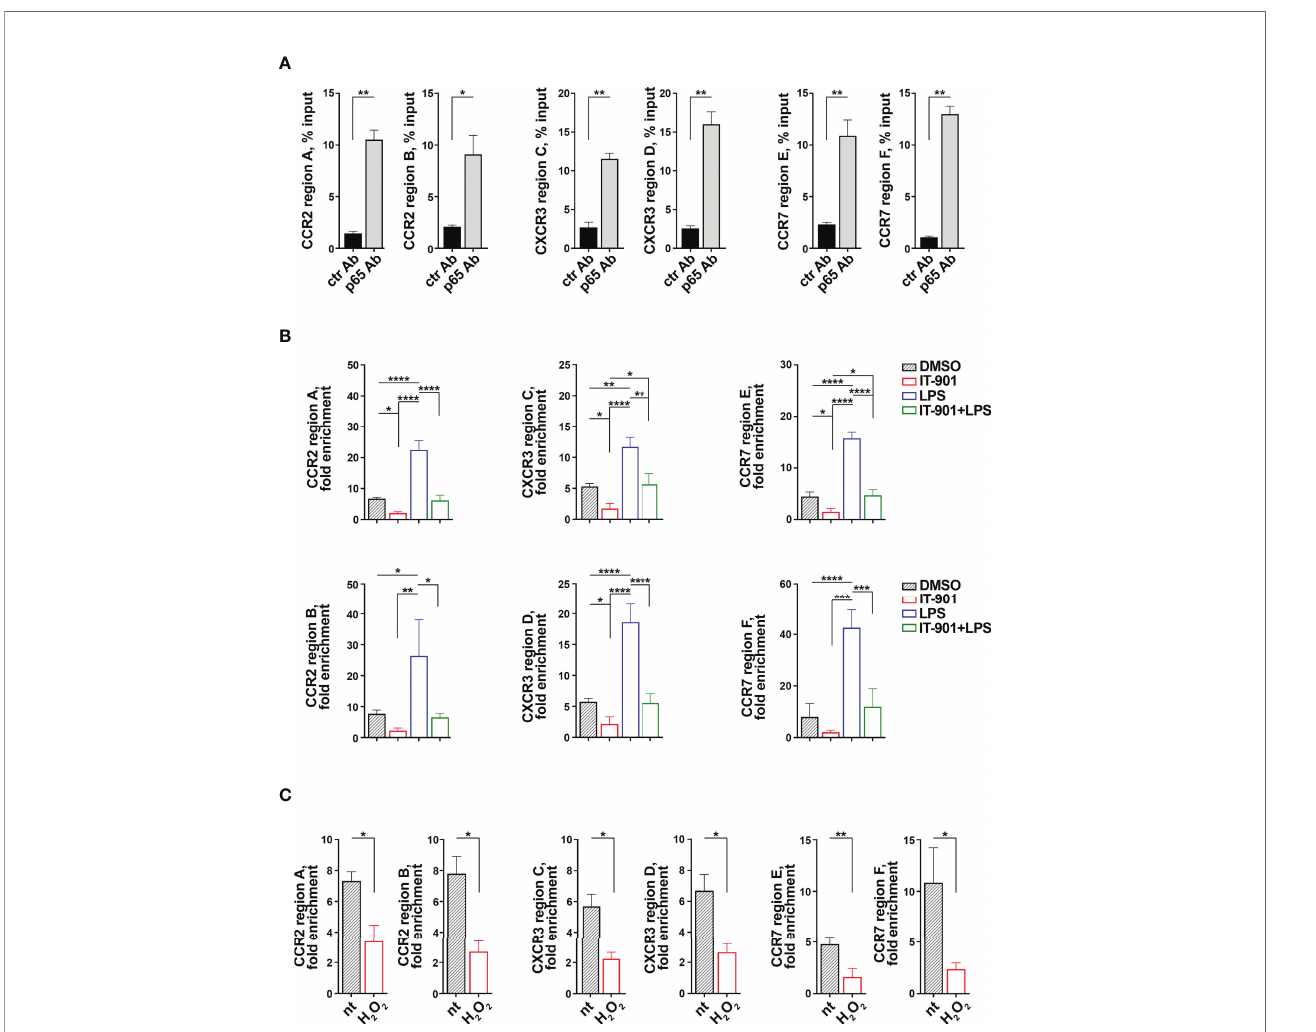
FIGURE 3 | The p65 subunit of NF- k B binds to the ccr2, cxcr3 and ccr7 promoters in MEC-1 cells. (A) ChIP assays of nuclear extracts of MEC-1 cells using either anti-NF- k B p65 (p65 Ab) or control unspeci fi c Rabbit IgG (ctr Ab) antibodies. Selected regions of the ccr2, cxcr3 and ccr7 promoters containing putative binding sites for the p65 subunit of NF- k B were ampli fi ed by qRT-PCR. Data are presented as percentage of input DNA (n = 4). (B) ChIP assays of nuclear extracts of MEC- 1 cells treated either with DMSO or with 1 m M IT-901 or 10 m M LPS or the combination of both for 30 min at 37°C and then subjected to qRT-PCR as described above. Data are presented as fold enrichment (percentage of input DNA of p65-Ab IP samples vs ctr Ab samples) (n = 3). (C) ChIP assays of nuclear extracts of MEC-1 cells either untreated or treated with 100 m M H 2 O 2 for 30 min at 37°C and then subjected to qRT-PCR as described above. Data are presented as fold enrichment (percentage of input DNA of p65-Ab IP samples vs ctr Ab samples) (n = 3). The relative gene transcript abundance was determined on triplicate samples using the ddCt method. Mean ± SD. (B) Anova two-way test, Multiple Comparison. (A, C) Paired t test. p ≤ 0.0001, ****; p ≤ 0.001, ***; p ≤ 0.01, **; p ≤ 0.05,